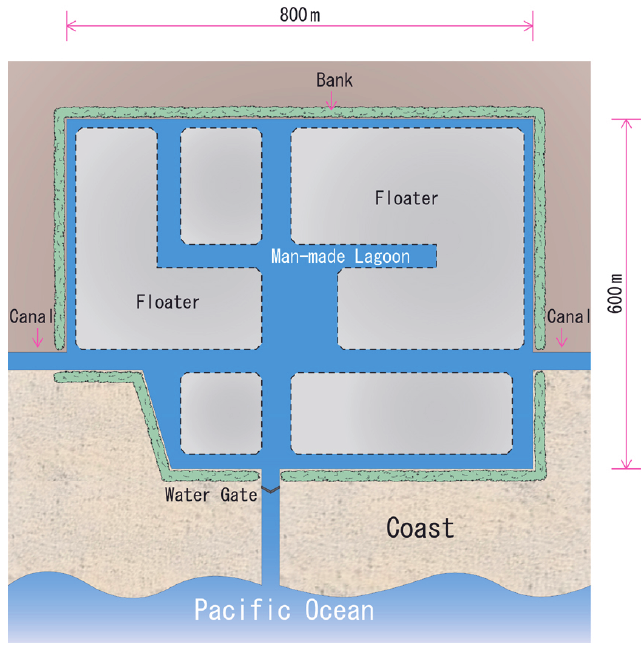
Figure 8. Plan view of the reconstruction for Arahama coastal area.